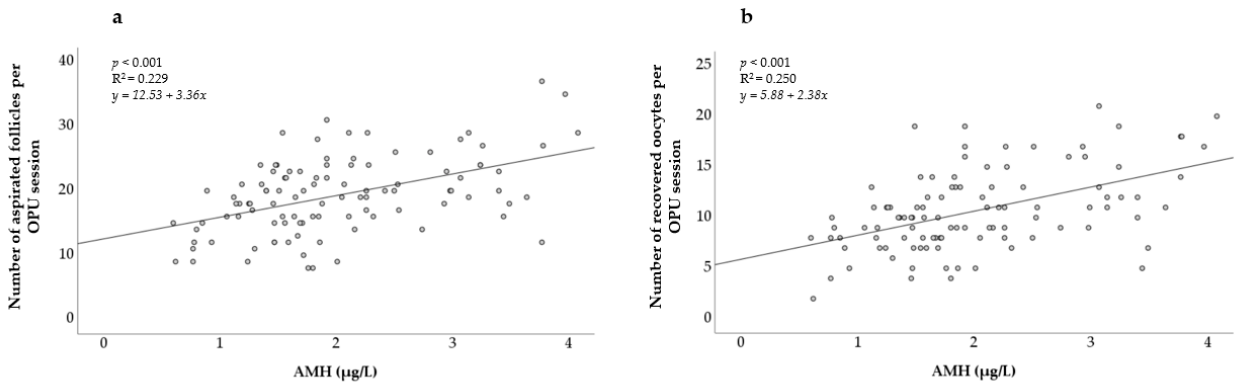
Figure 1. Association between AMH concentration and ( a ) number of aspirated follicles; ( b ) number of recovered oocytes. AMH = Anti-Müllerian hormone. R 2 = coefficient of determination.